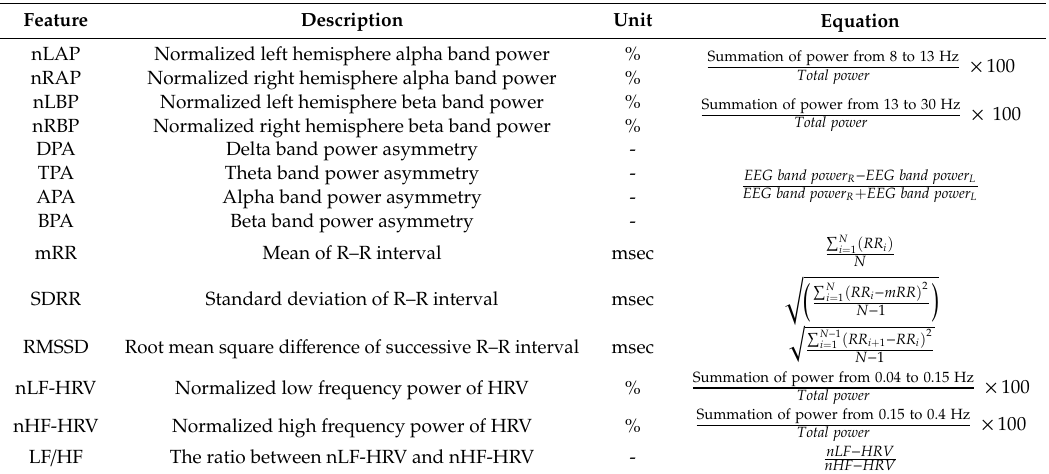
Table 1. Description of the electroencephalogram (EEG) and heart rate variability (HRV) features used in the stress